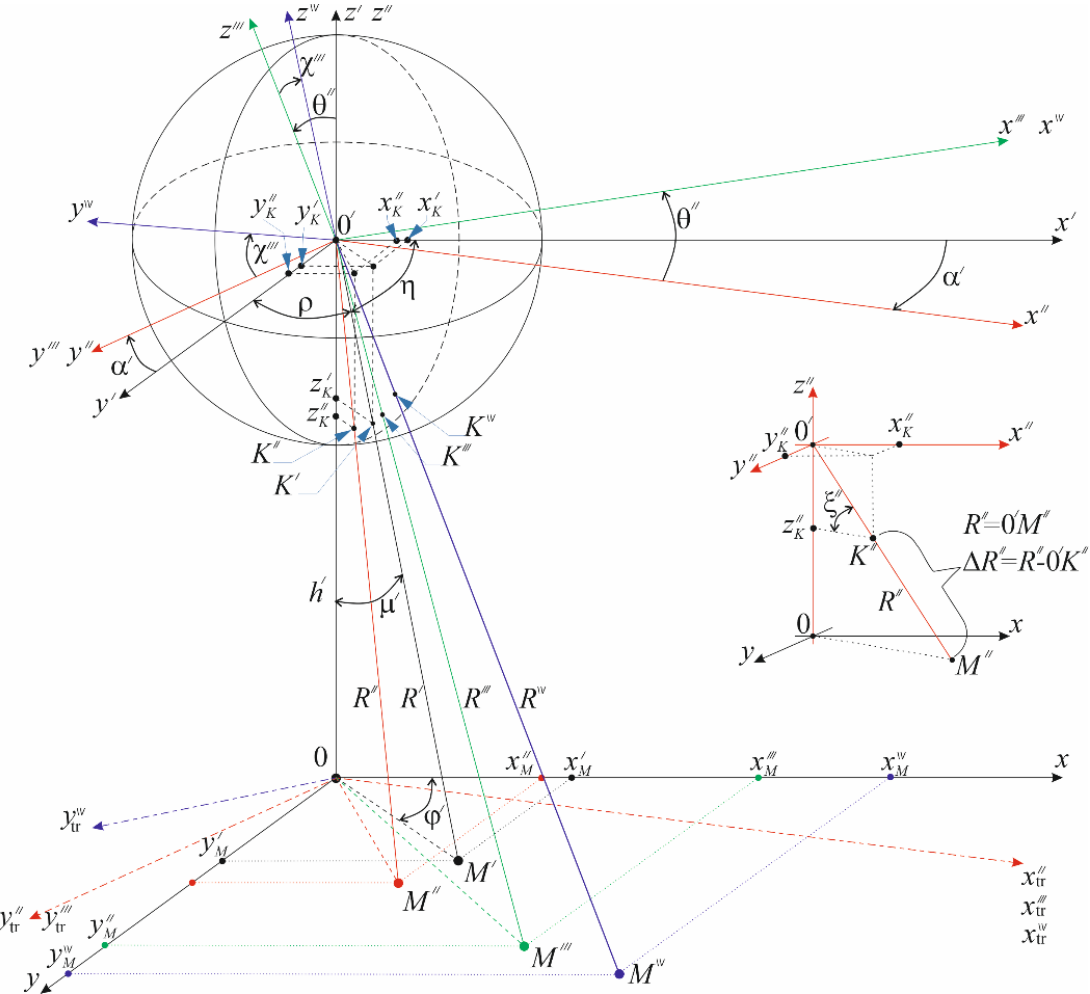
Figure 2. The geometry of the problem, which considers the presence of yaw, pitch, and roll angles in the aircraft movement.